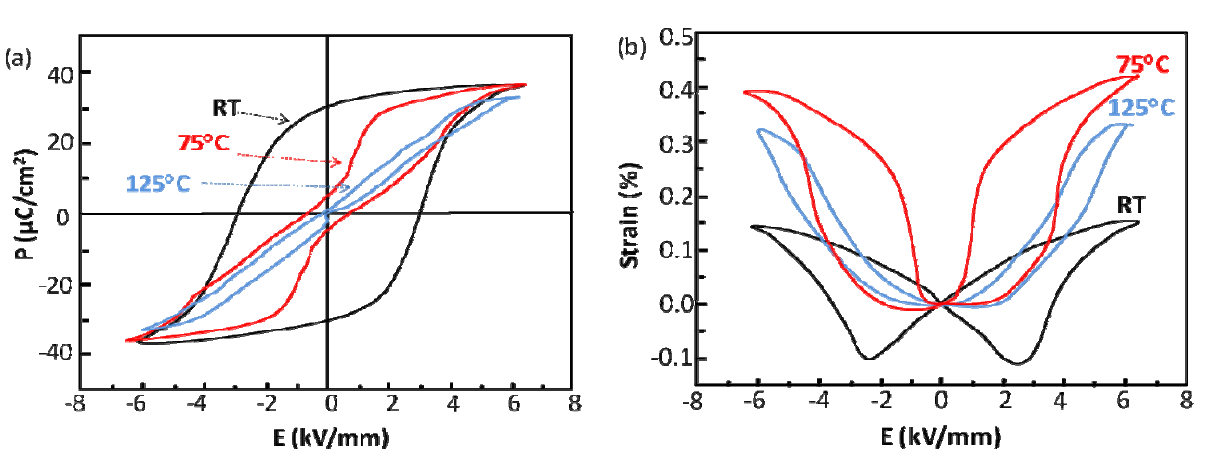
Figure 9. Polarization (a) and strain (b) loops of 0.93 NBT-0.05 BT-0.02 KNN ceramics at several temperatures, reproduced from Zhang et al.